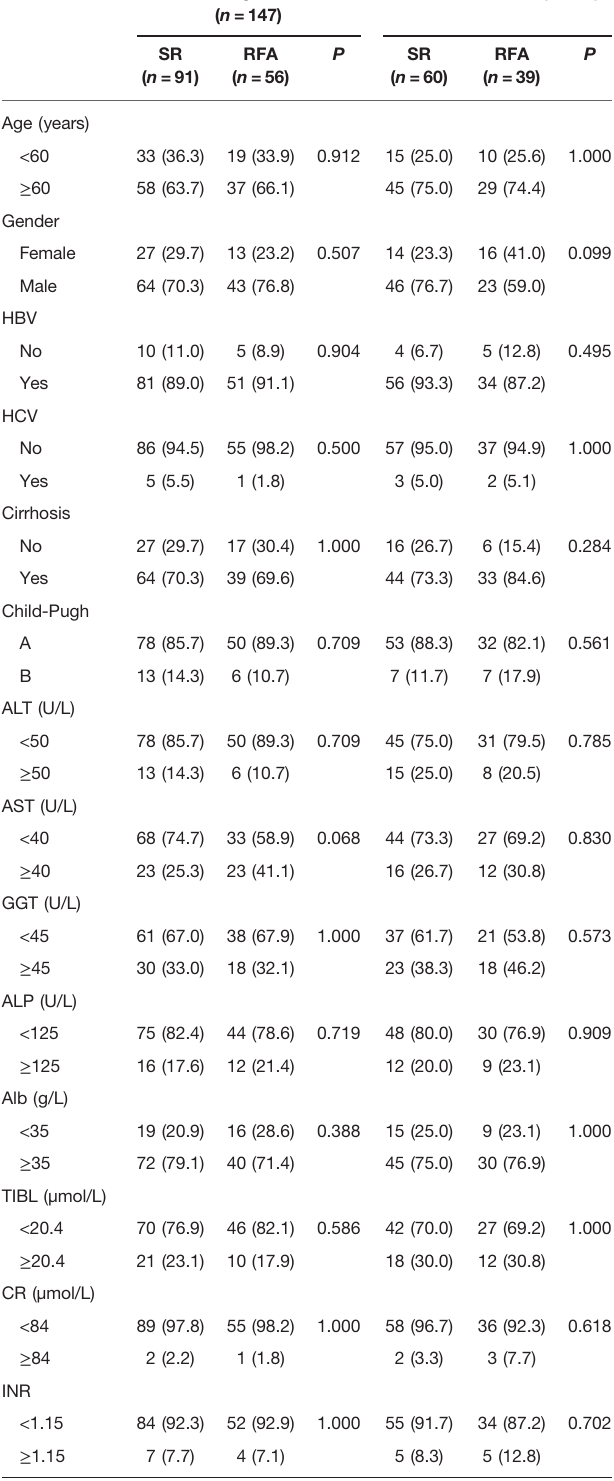
TABLE 2 | Comparison of clinicopathological variables between SR and RFA in CTC-positive cohort. Variable Training cohort ( n